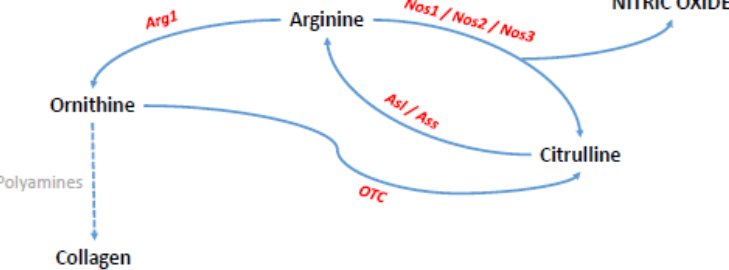
Figure 1. Schematic representation of the arginine-citrulline-nitric oxide metabolism. Arginine can be converted into citrulline by one of the isoforms of nitric oxide synthase (NOS1, NOS2 and NOS3). During the conversion, nitric oxide is produced. Citrulline can be converted back into arginine by the enzymes arginosuccinate synthetase (ASS) and arginosuccinate lyase (ASL). Conversion of arginine into ornithine is mainly via arginase 1 (Arg1). Ornithine acts as a precursor for collagen synthesis through conversion via several polyamine molecules. Along a second route, it can be converted into citrulline by the enzyme ornithine transcarbamylase (OTC).